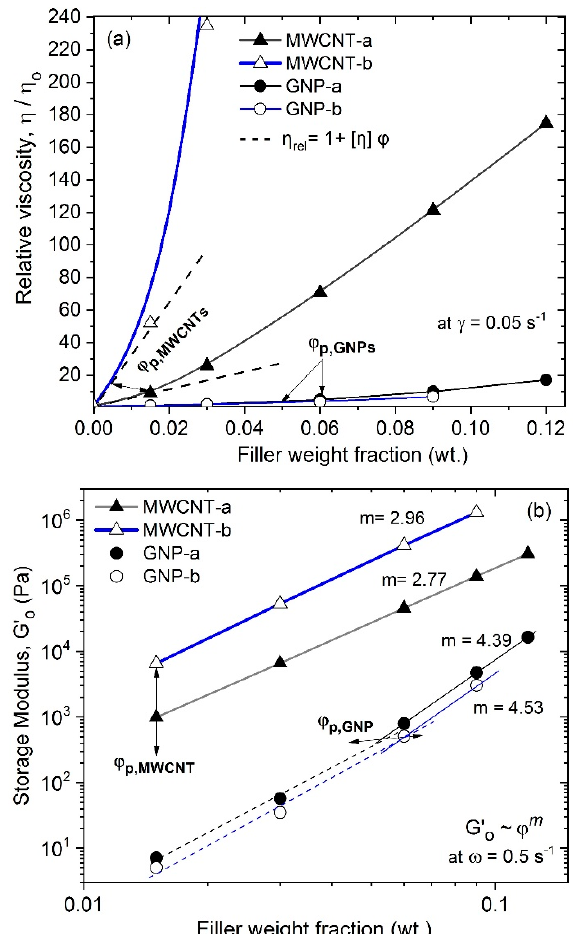
Figure 2. ( a ) Relative viscosity (at 𝛾(cid:4662) = 0.05 s − 1 ) and ( b ) terminal storage modulus (at ω = 0.5 s − 1 ) vs. filler content for nanocomposites with MWCNT and GNP, series NC-a and NC-b. Arrows show the percolation threshold.